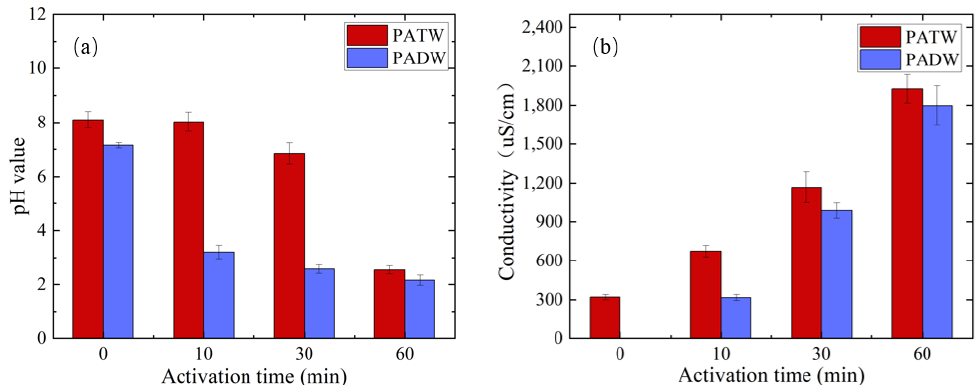
Figure 9. The ( a ) pH value and ( b ) conductivity of PATW and PADW as a function of activation